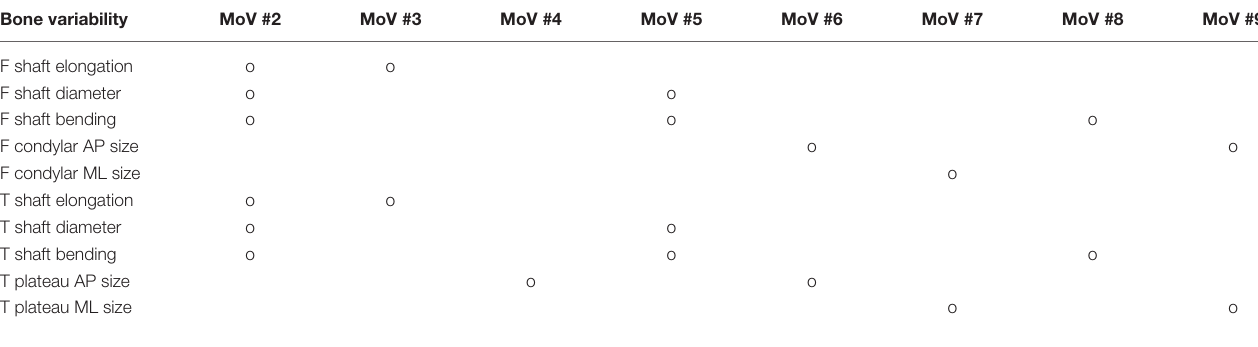
TABLE 2 | Morphological variability of femur (F) and tibia (T) and relative alignments mapped onto the MoVs from 2 to 9. Bone